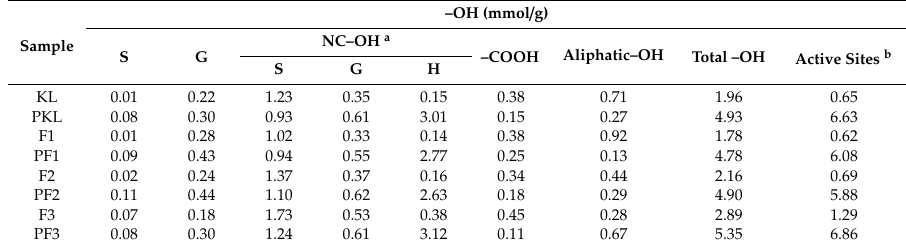
Figure 5. 31 P NMR spectrum of lignin and its corresponding phenolated sample. Table 3. Quantitative 31 P NMR Analyses of Lignin and its Corresponding Phenolated